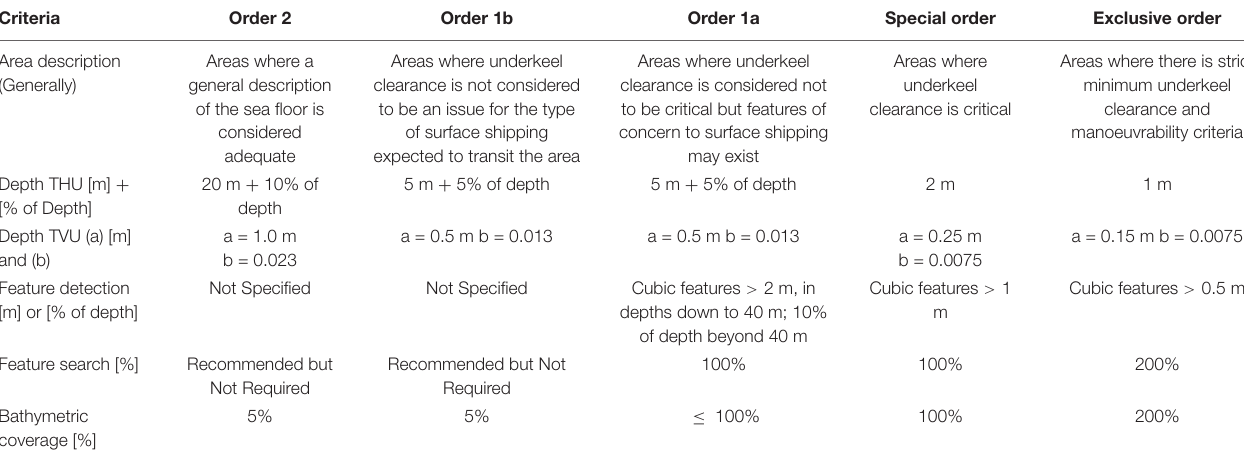
TABLE 2 | IHO S-44 minimum bathymetry standards for safety of navigation hydrographic surveys.